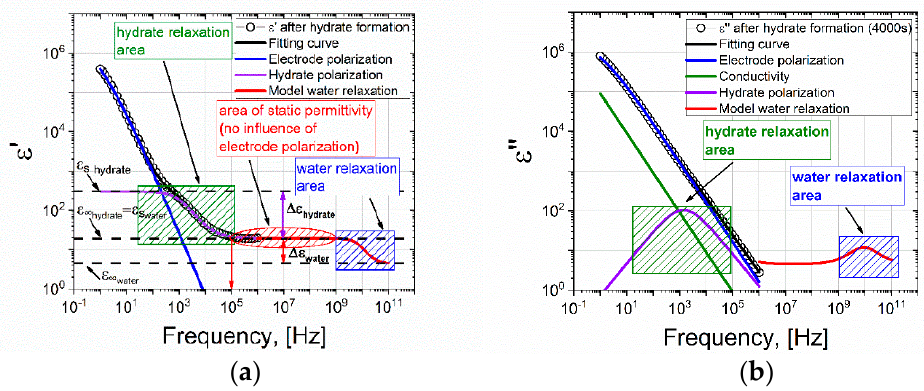
Figure 6. ( a ) Real and ( b ) imaginary parts of the dielectric spectrum of the water-gas system at the time t = 4000 s, after the formation of the hydrate (273 K, 9 MPa). The black line is the fitting function constructed in accordance with equation (3); the blue line is the contribution of electrode polarization; the green line represents DC conductivity; the violet line is the additional area of dispersion; and the red line is the model spectrum of water.